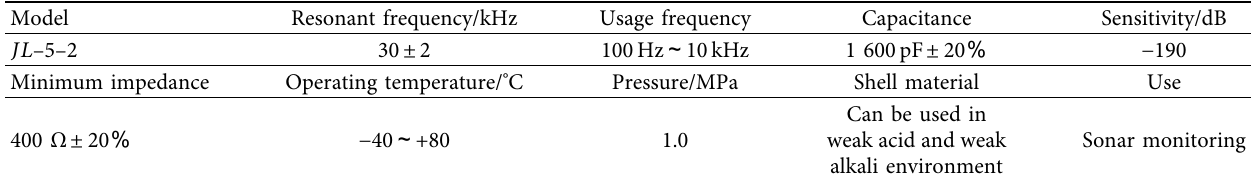
Table 3: Sonar-receiving transducer